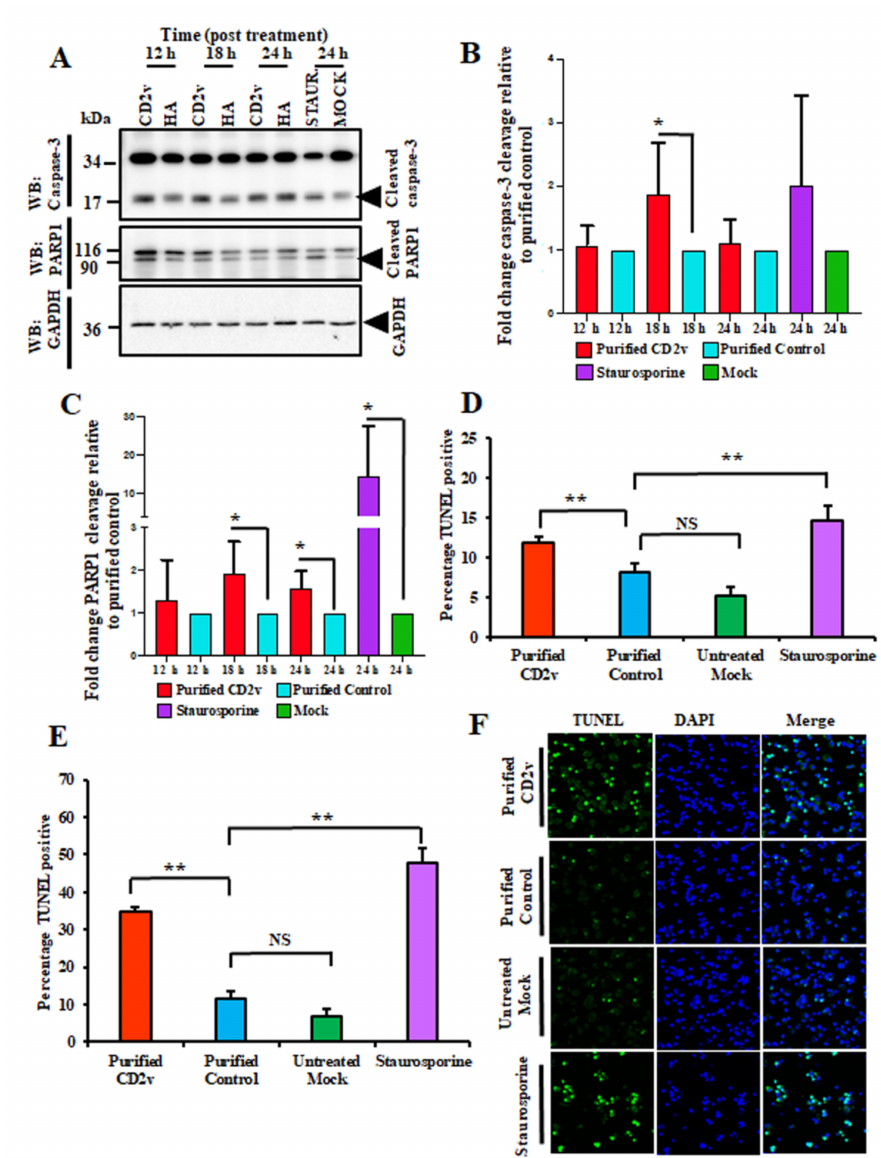
Figure 8. Purified CD2v protein induces apoptosis in swine PBMCs. ( A ) Caspase-3 and PARP1 cleavage. Swine PBMCs were treated with purified CD2v, purified control or staurosporine (positive control) and whole cell lysates were obtained at various times post treatment, resolved by SDS-PAGE, blotted and probed with antibodies against Caspase-3, PARP1 and GAPDH (loading control). ( B ) Densitometric analysis showing the fold change in caspase-3 activation relative to the purified control treatment. The caspase-3 results are the mean values of six independent experiments (18 h, p = 0.042). ( C ) Densitometric analysis showing fold changes in PARP1 cleavage relative to the purified control treatment. Results are the mean values of six independent experiments (18 h, p = 0.026; 24 h, p = 0.018). ( D ) TUNEL assay in lymphocytes. Swine PBMCs treated as in A were fixed at 18 h post treatment and processed for the TUNEL assay as described in Materials and Methods. Approximately 5000 lymphocytes (6–9 µ m in diameter) were counted/slide and results are shown as mean values from three independent experiments. p -values for purified CD2v relative to the purified control and mock were 0.004 and 0.006, respectively. ( E ) TUNEL assay in macrophages. Swine macrophages (16–23 µ m in diameter) treated as in ( A ) were fixed at 18 h post treatment and processed for the TUNEL assay as described in Materials and Methods. Approximately 1600 cells/slide were counted and results are mean values of three independent experiments. p -values for purified CD2v relative to the purified control and mock were 0.004 and 0.003, respectively. ( F ) Representative confocal images of the TUNEL assay under conditions outlined in ( E ). Green, TUNEL; Blue, DAPI. (*, p < 0.05 and **, p <